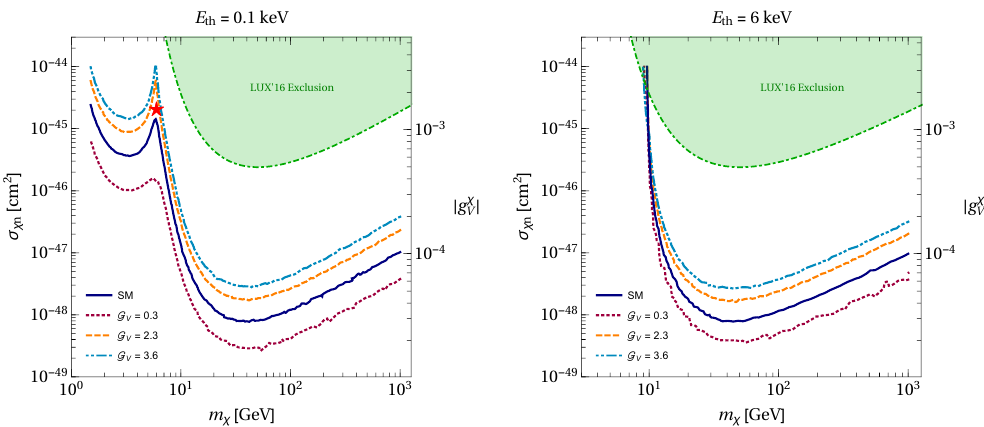
Figure 4 . Neutrino (cid:13)oor for the vector mediator case in the plane ( m (cid:31) ; (cid:27) (cid:31)n ) and ( m (cid:31) ; j g (cid:31) results are for the LUX-ZEPLIN experiment with two di(cid:11)erent energy thresholds: a very low one, E th =0.1 keV (left), and the nominal threshold used in the experiment, E th = 6 keV (right). The SM neutrino (cid:13)oor (dark blue) is shown, along with the most extreme case still allowed for the vector model ( G V = 3 : 6, light blue), an intermediate case ( G V = 2 : 3, orange), as well as a case where the neutrino (cid:13)oor can be smaller than the SM one ( G V = 0 : 3, red). The axis corresponding to the j g (cid:31) coupling was obtained considering (cid:3) (cid:0) 2 = 10 (cid:0) 6 GeV 2 . V